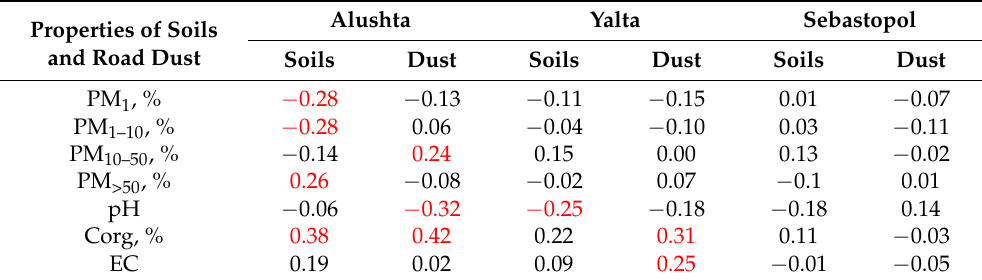
Table 3. Correlation coefficients between the benzo(a)pyrene content in soils, road dust and their physicochemical properties in Alushta, Yalta and Sebastopol. Properties of Soils and Road